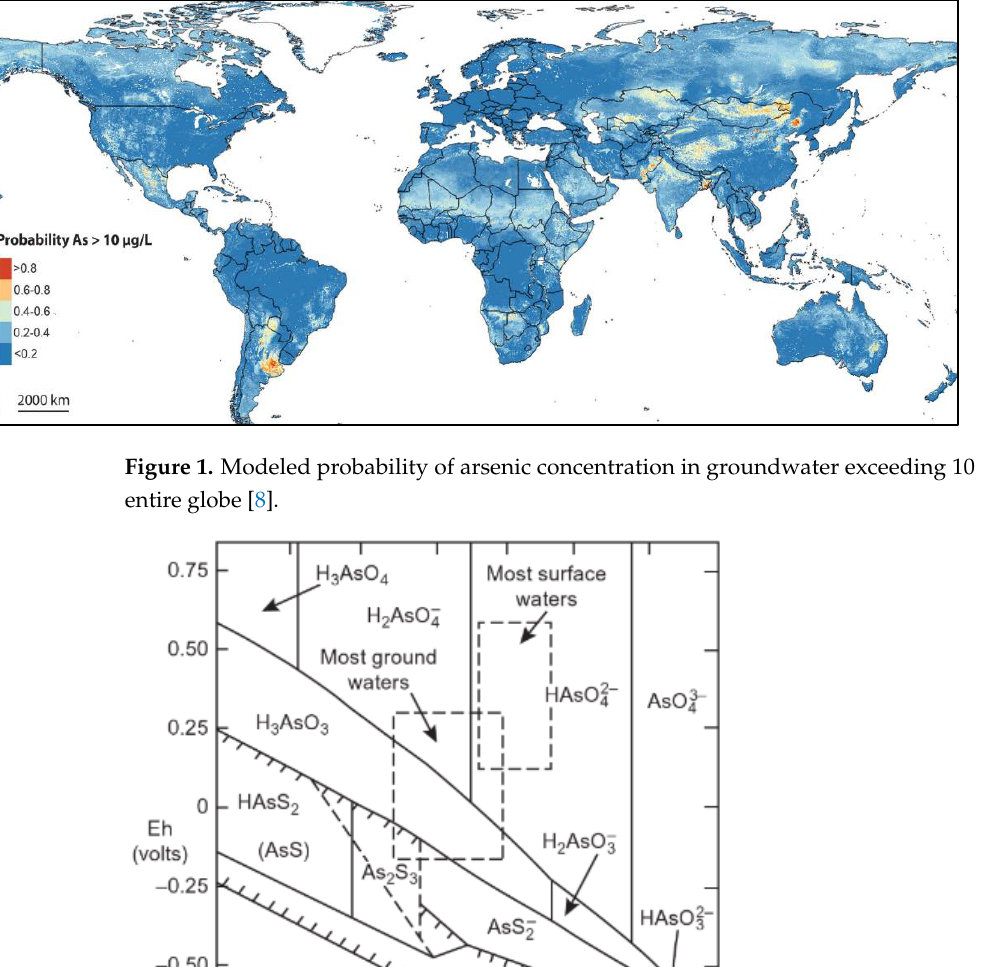
Figure 1. Modeled probability of arsenic concentration in groundwater exceeding 10 μg/L for the entire globe [8].